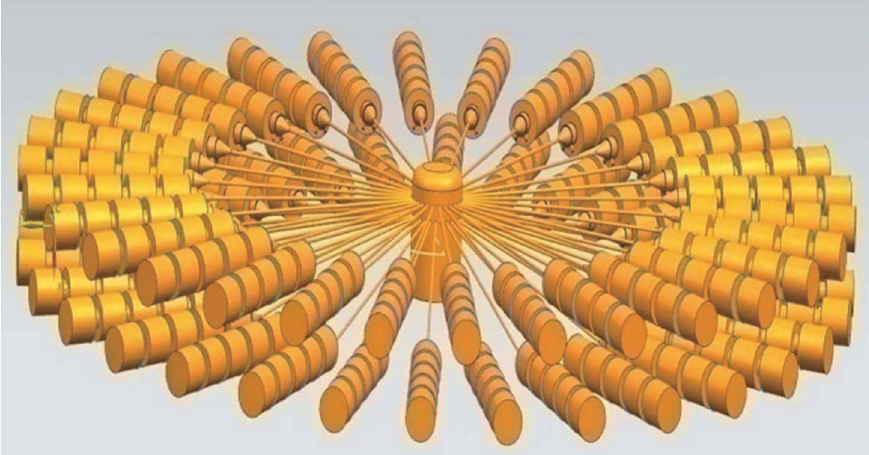
FIG. 1. Schematic drawing of the fusion facility concept. Sixty LTD modules in two layers are connected in parallel to current convergent structures where the fusion load is fielded to the end. In each module, 50 LTD cavities are connected with vacuum MIVA. The output of the module is connected to the conical transmission line via a 12-m coaxial MITL. The diameter and the height of the facility are about 65 m and 10 m, respectively.